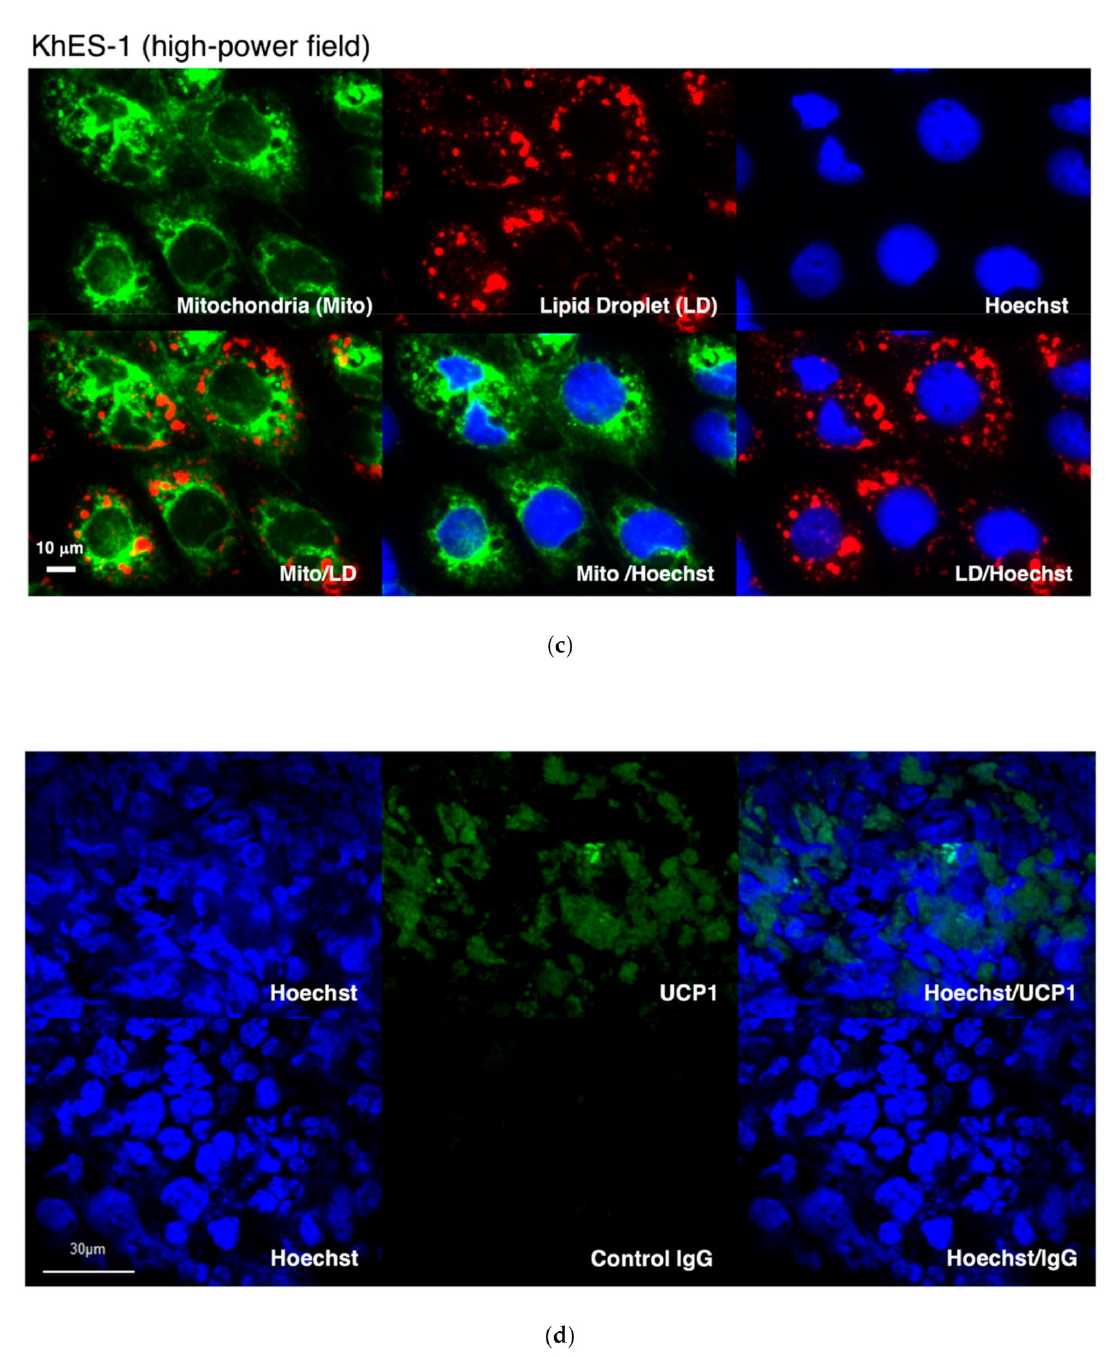
Figure 2. Live cell staining and immunostaining of fixed cells. The live Day 9 di ff erentiated cells for KhES-1 ( a ) and KhES-3 ( b ) were stained by MitoBright Green (green) (Dojindo Molecular Technologies, Inc., Kumamoto, Japan), a mitochondrial probe, and Lipi-Red (red), a probe for lipid droplets, with nuclear counter staining using Hoechst 33342. High-power field images of live cell staining of KhES-1 were shown ( c ). Each cell contained abundant mitochondria and multilocular lipid droplets, which are characteristic of BA. Alternatively, the di ff erentiated KhES-1 cells were subjected to immunostaining using an anti-UCP1 antibody ( d